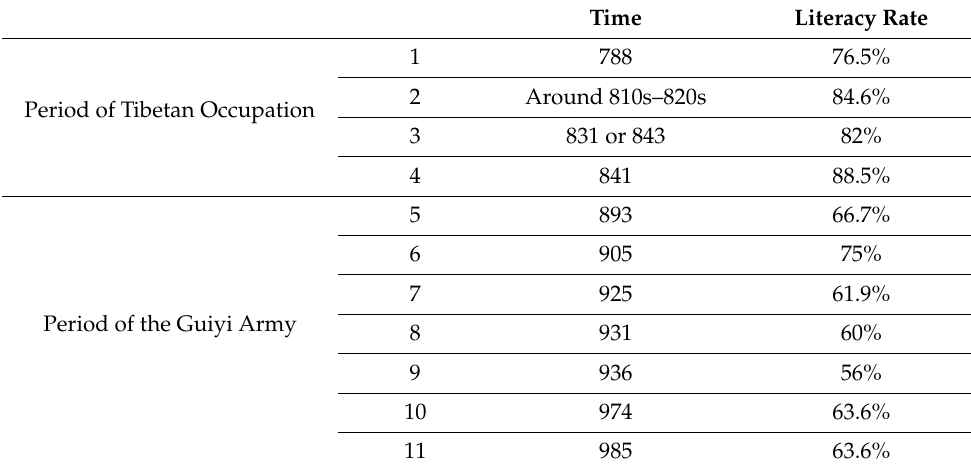
Table 8. The literacy rate of Dunhuang monks in the period of Tibetan occupation and the period of the Guiyi Army.